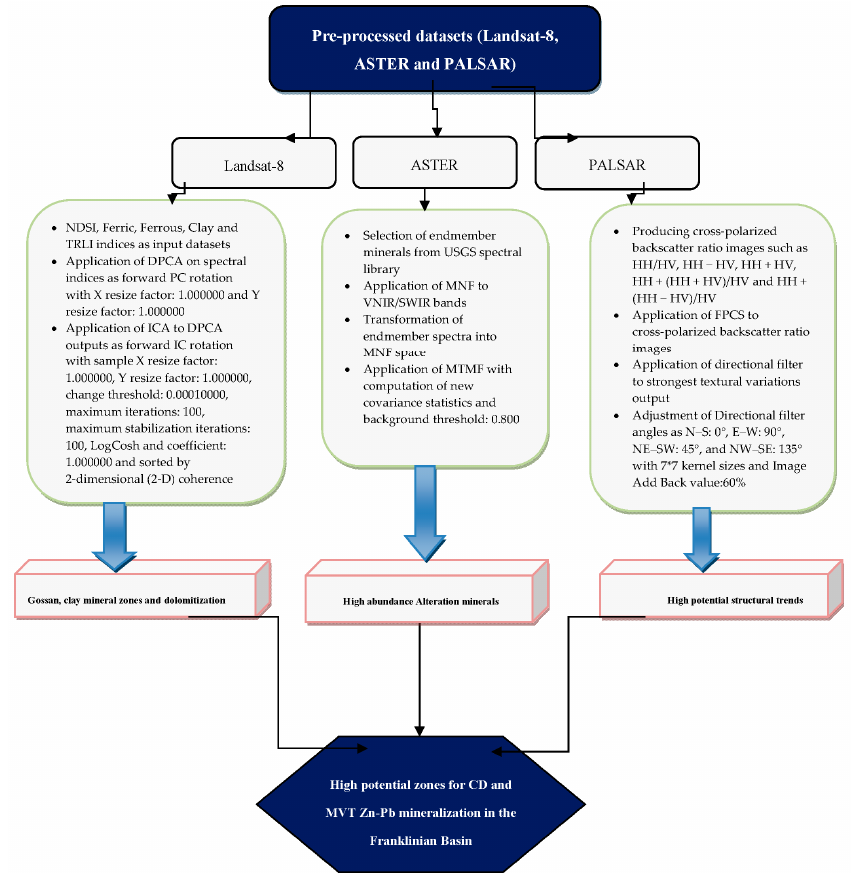
Figure 4. An overview of the methodological flowchart used in this study and performance characteristics of image processing